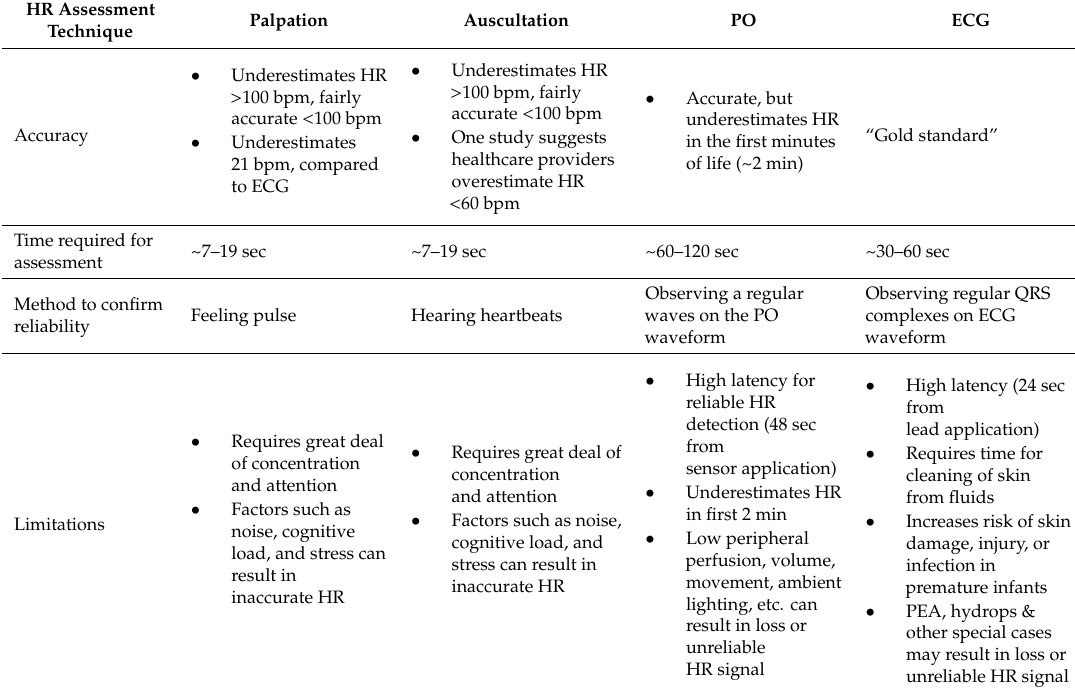
Table 1. Recommended techniques for heart rate assessment, associated outcomes including accuracy, time required for assessment, and reliability of technique, and limitations. Abbreviations: HR: heart rate; PO: pulse oximetry ECG: electrocardiography; bpm: beats per minute; sec: